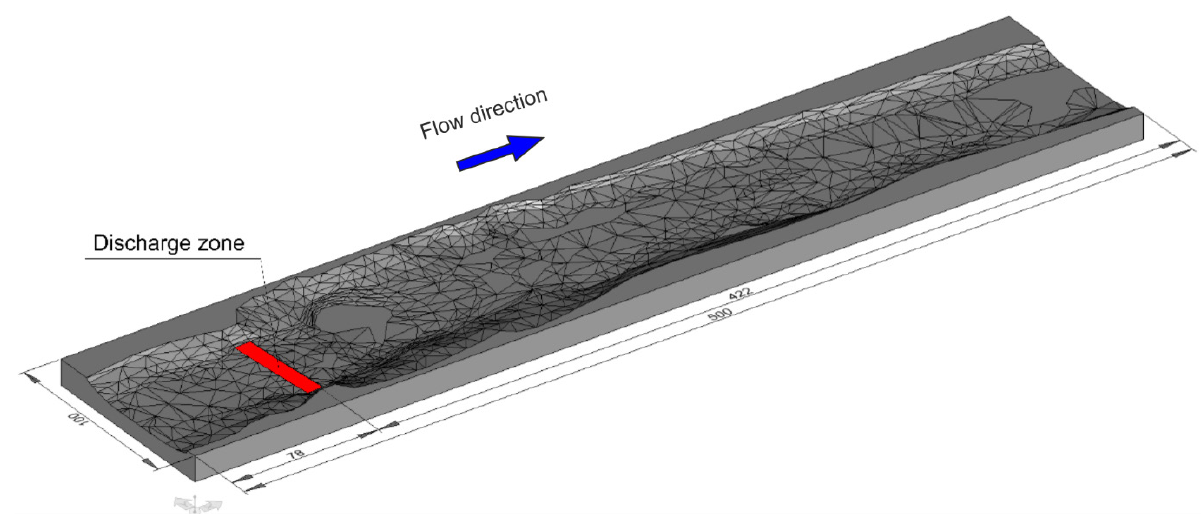
Figure 6: Three-dimensional model of the Odra riverbed, with the brine outflow zone